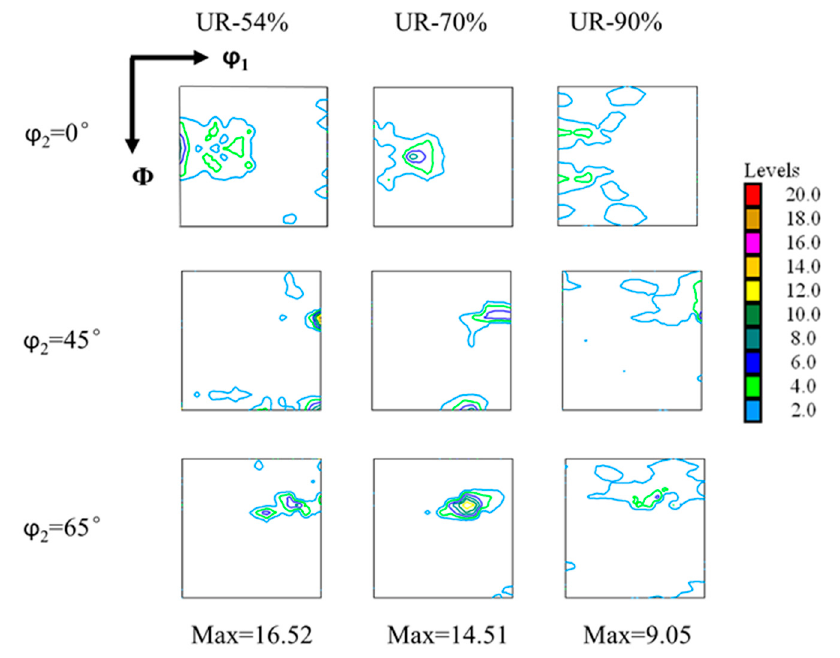
Figure 3. The sections ϕ 2 = 0 ◦ , 45 ◦ , 65 ◦ in the ODFs of Cu-0.1Al alloy under unidirectional rolling.